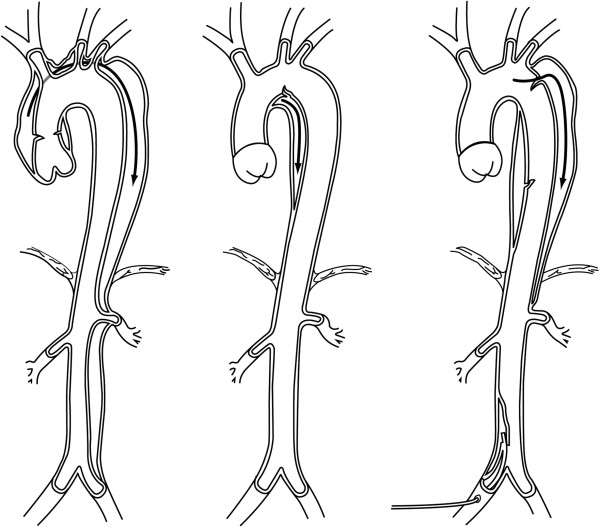
Stanford and De Bakey classification of aortic dissection. The image on the left represents De Bakey I and II/Stanford A; the middle image Stanford B; the right image De Bakey IIIa and b/Stanford B. De Bakey I; -origin in ascending aorta; extends to include at least arch; -usually surgical management. De Bakey II; -originates in and is confined to ascending aorta; -usually surgical management. De Bakey IIIa; -originates in descending aorta; usually extends distally; -usually nonsurgical management De Bakey IIIb; -originates in descending aorta; extends distally below diaphragm; -usually nonsurgical management. Stanford A; -all dissections involving ascending aorta; -management usually surgical. Stanford B; -all dissections not involving ascending aorta; -management usually nonsurgical.